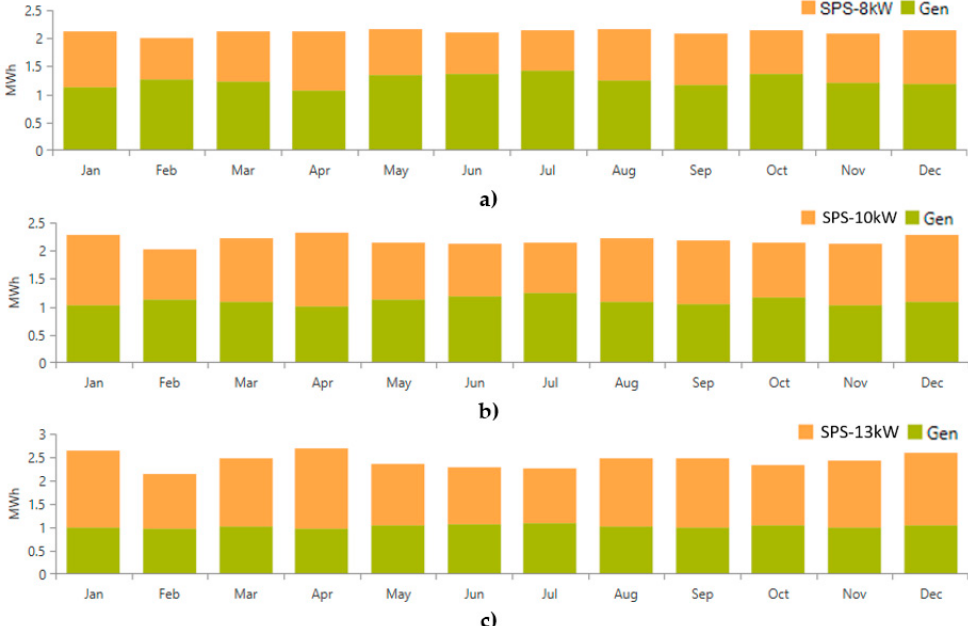
Figure 8. Production of the SPS and the diesel generator in the 15th year of the project: ( a ) scenario 3, ( b ) scenario 8, and ( c ) scenario 13.